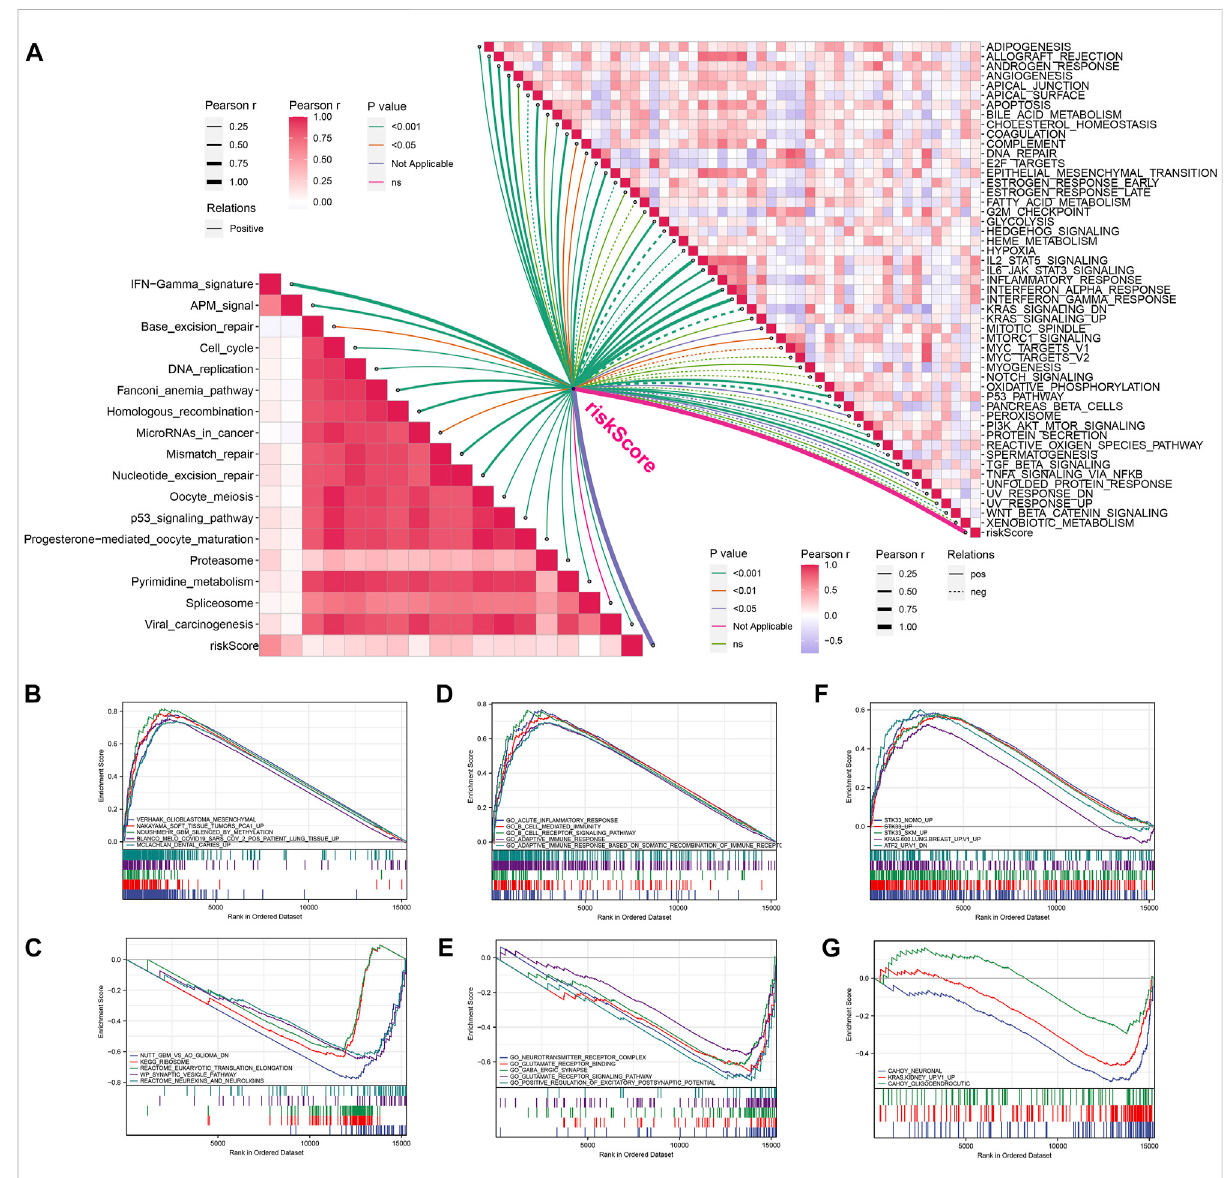
FIGURE 5 Enrichment analysis of signal pathways. (A) Correlations between riskcore and enrichment score of immunotherapy prediction pathway and hallmark gene set. (B,C) GSEA analysis between high-risk (B) and low-risk (C) groups based on curated gene set. (D,E) GSEA analysis between high- risk (D) and low-risk (E) groups based on Ontology gene set. (F,G) GSEA analysis between high-risk (F) and low-risk (G) groups based on oncogenic signature gene